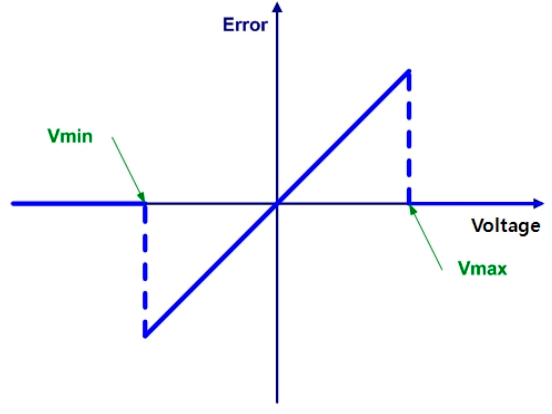
Figure 4. Protection logic rule in the dead-band step.